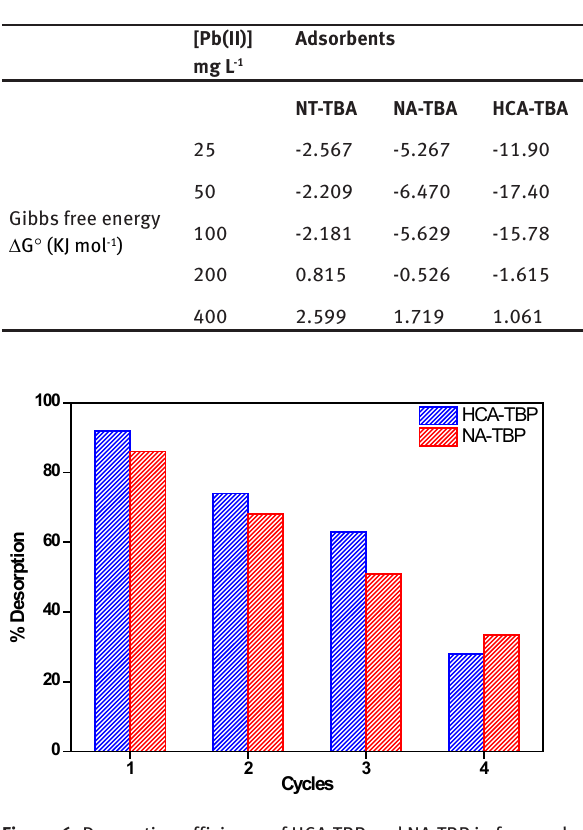
Table 3: Gibbs free energy values at different initial Pb(II) concentrations for original and chemically pretreated TBP